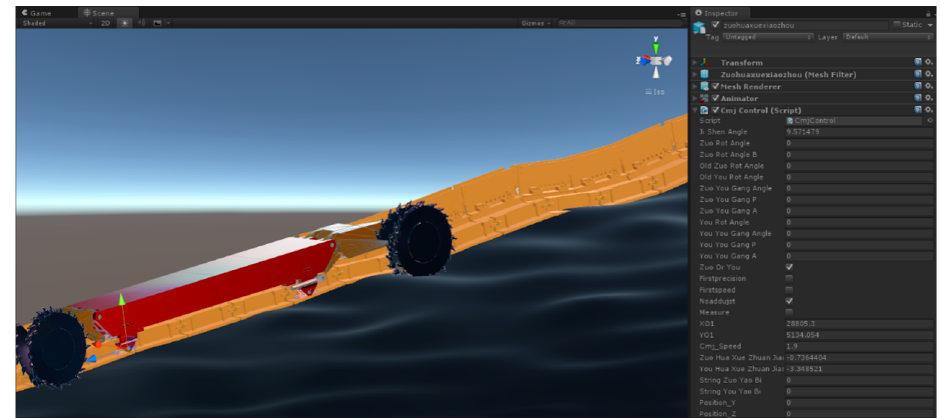
Figure 9. Effect diagram of combined operation of shearer and scraper conveyor.